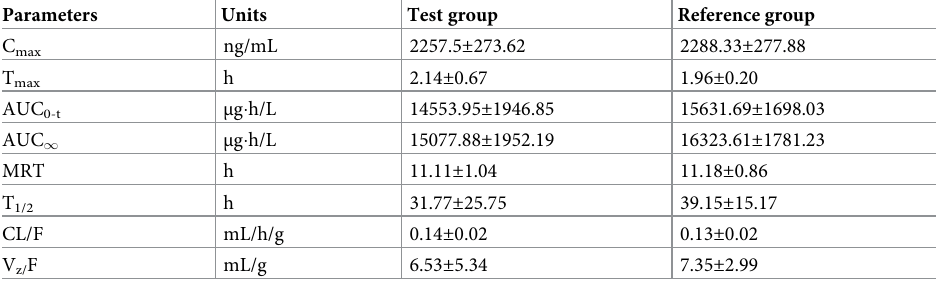
Table 3. The main pharmacokin etic parameters of IMD in the test and reference